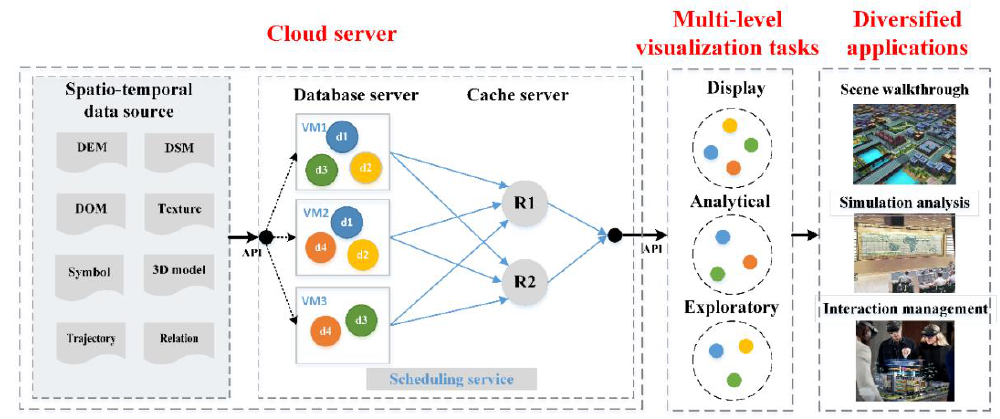
Figure 1. Spatiotemporal data scheduling framework.